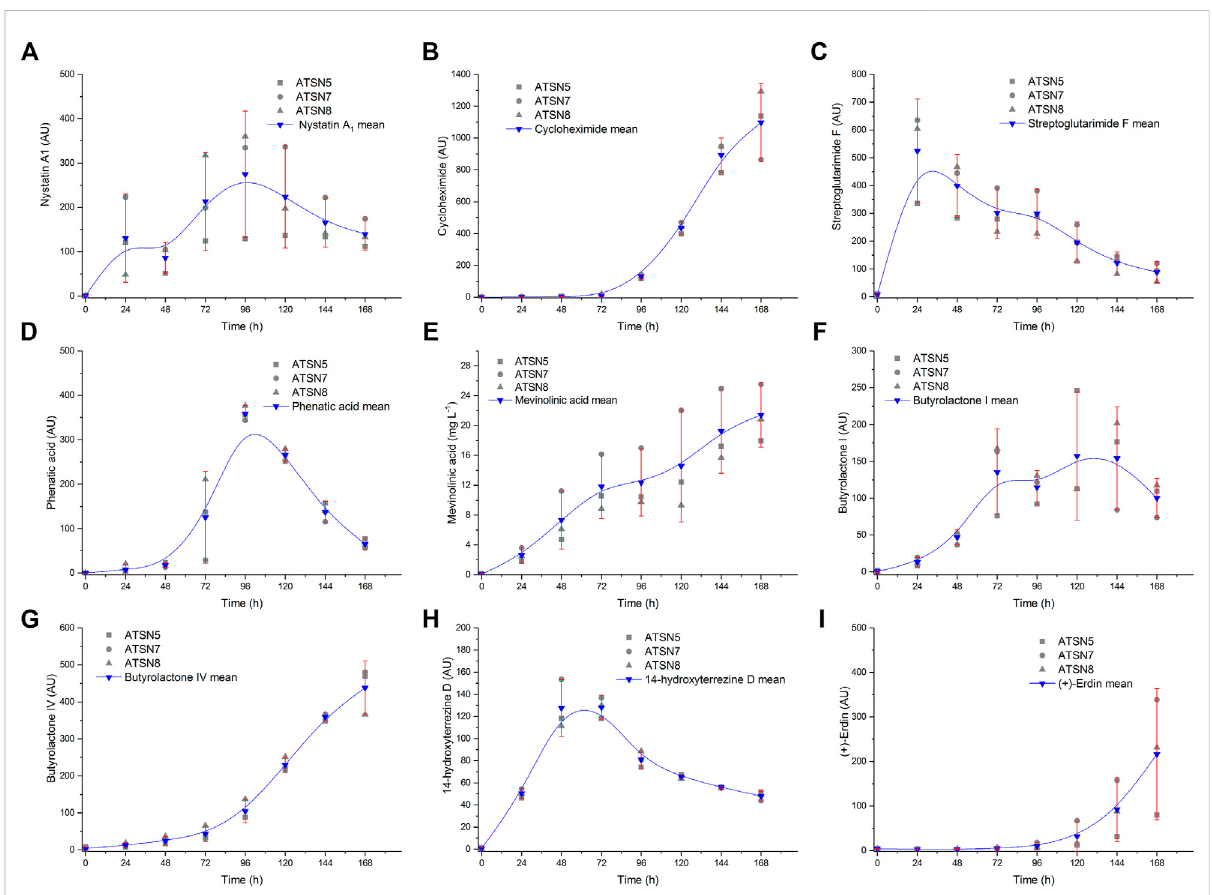
FIGURE 2 Replicability analysis of secondary metabolites levels determined over the course of the study for S. noursei (A – D) and A. terreus (E – I) monocultures. The replicability was tested with the use of the con fi dence function in OriginPro 2017 software (OriginLab, United States) which returns the con fi dence interval for the mean value. Calculations were carried out for the signi fi cance level α = 0.05 based on three bioreactor experiments conducted in the same conditions, namely the monocultures in ATSN5, ATSN seven and ATSN8 runs. AU — auxiliary